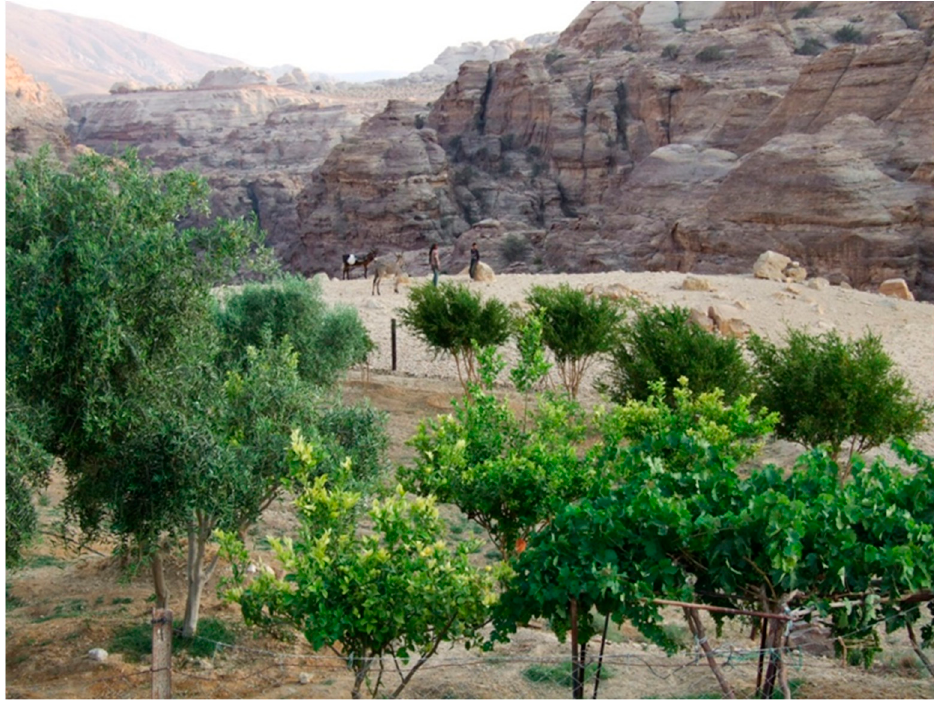
Figure 16. Bedouin orchard near Petra, containing Mediterranean fruit trees. (Photograph: Y. Avni).